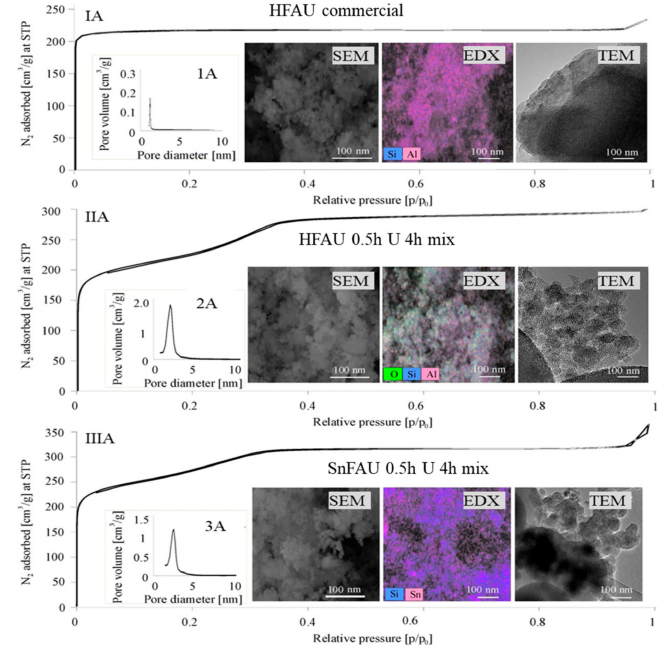
Figure 2. Isotherms of N 2 adsorption/desorption for materials based on zeolite faujasite (FAU) (from IA to IIIA ), pore size distribution (from 1A to 3A ) and SEM, SEM/EDX (Energy-dispersive X-ray spectroscopy) and TEM